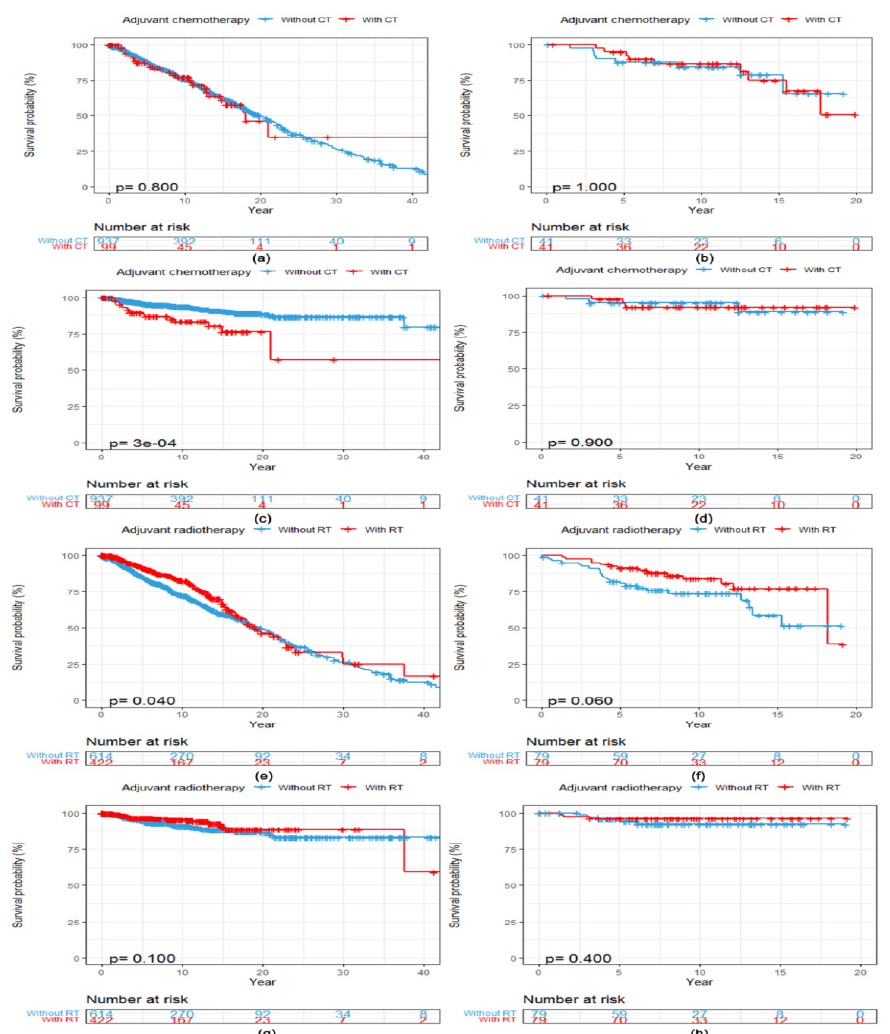
Figure 2. Kaplan–Meier curves showing a comparison of survival among patients with ACC of the breast according to adjuvant treatments. OS curves of patients stratified by adjuvant CT ( a ) before and ( b ) after PSM. BCSS curves of patients stratified by adjuvant CT ( c ) before and ( d ) after PSM. OS curves of patients stratified by adjuvant RT ( e ) before and ( f ) after PSM. BCSS curves of patients stratified by adjuvant RT ( g ) before and ( h ) after PSM. Abbreviations: ACC = adenoid cystic carci- noma of the breast; BCSS = breast cancer-specific survival; CT = chemotherapy; OS = overall survival; PSM = propensity score matching; RT = radiotherapy.